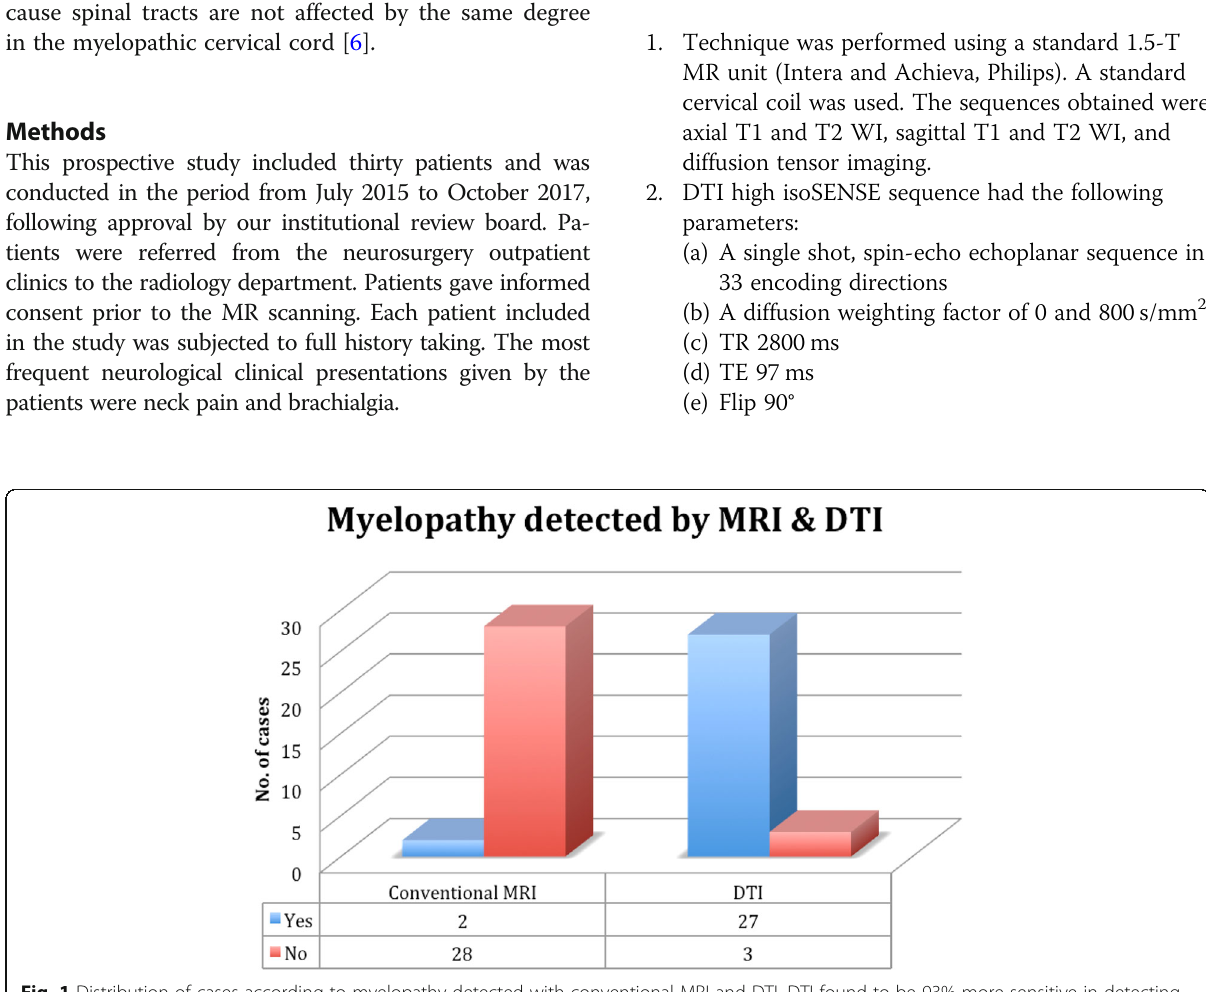
Clinical presentation Number of cases